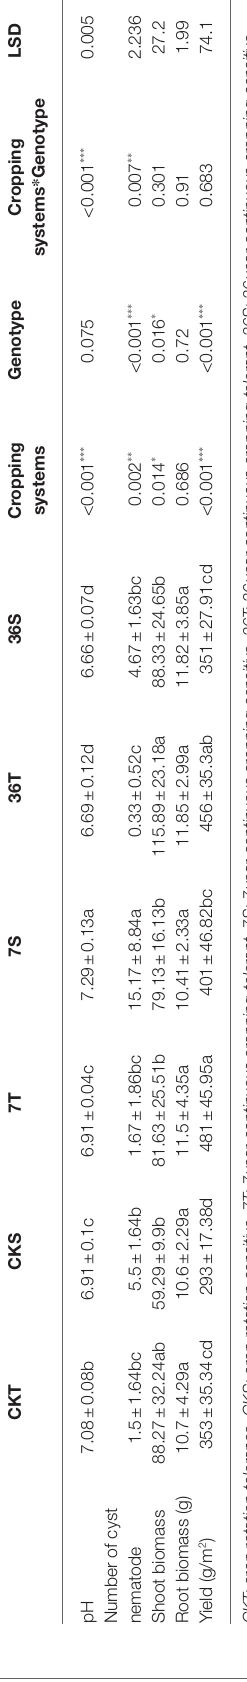
the rhizobacterial communities (PERMANOVA, p < 0.05; Figure 2; Supplementary Figure S2 ; Table 2 ). In more detail, rhizobacterial community structures differed between tolerant and sensitive soybean genotypes irrespective of cropping systems ( Supplementary Figure S3 ; Table 2 ).